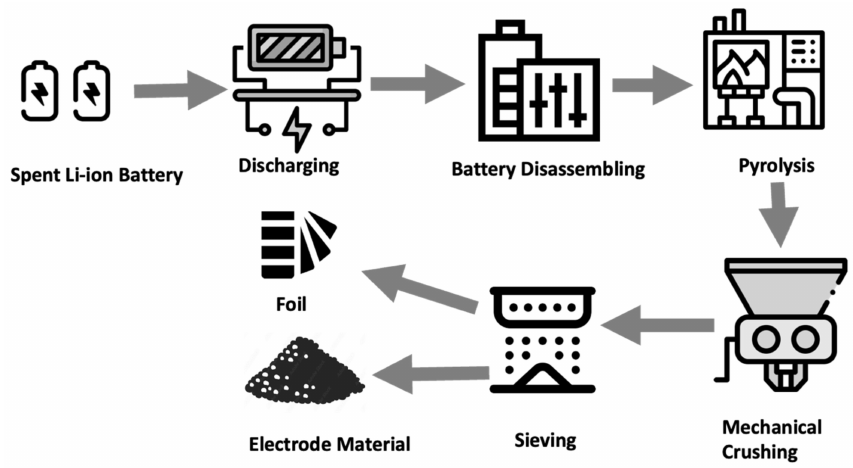
Figure 8. Process flow chart of conventional mechanical pre-treatment process